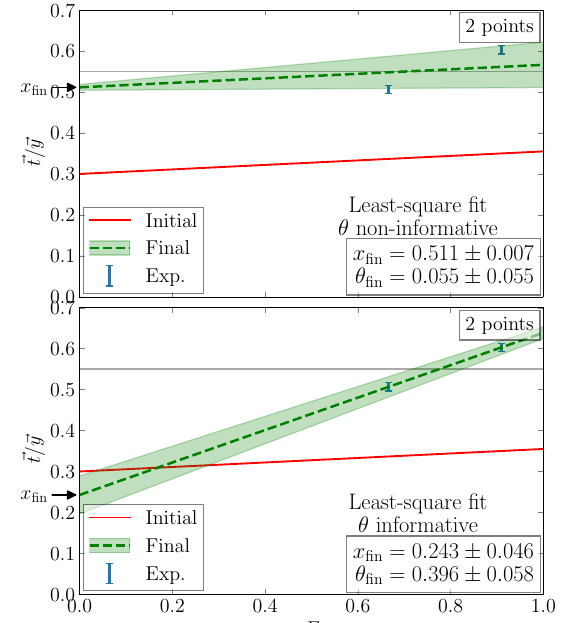
Figure 1. Analysis of the 2 points data set with the toy model data by Bayesian inference with and without fit of θ .